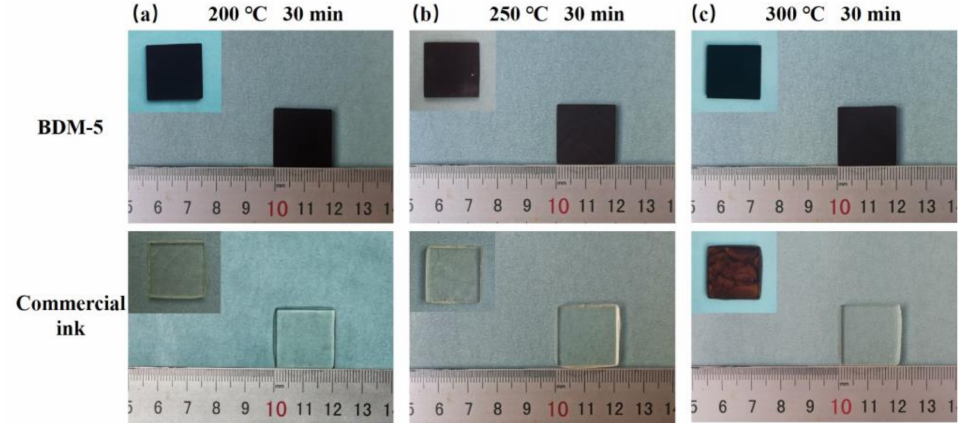
Figure 8. Comparison of high-temperature resistance between BDM-5 ink and commercial ink at ( a